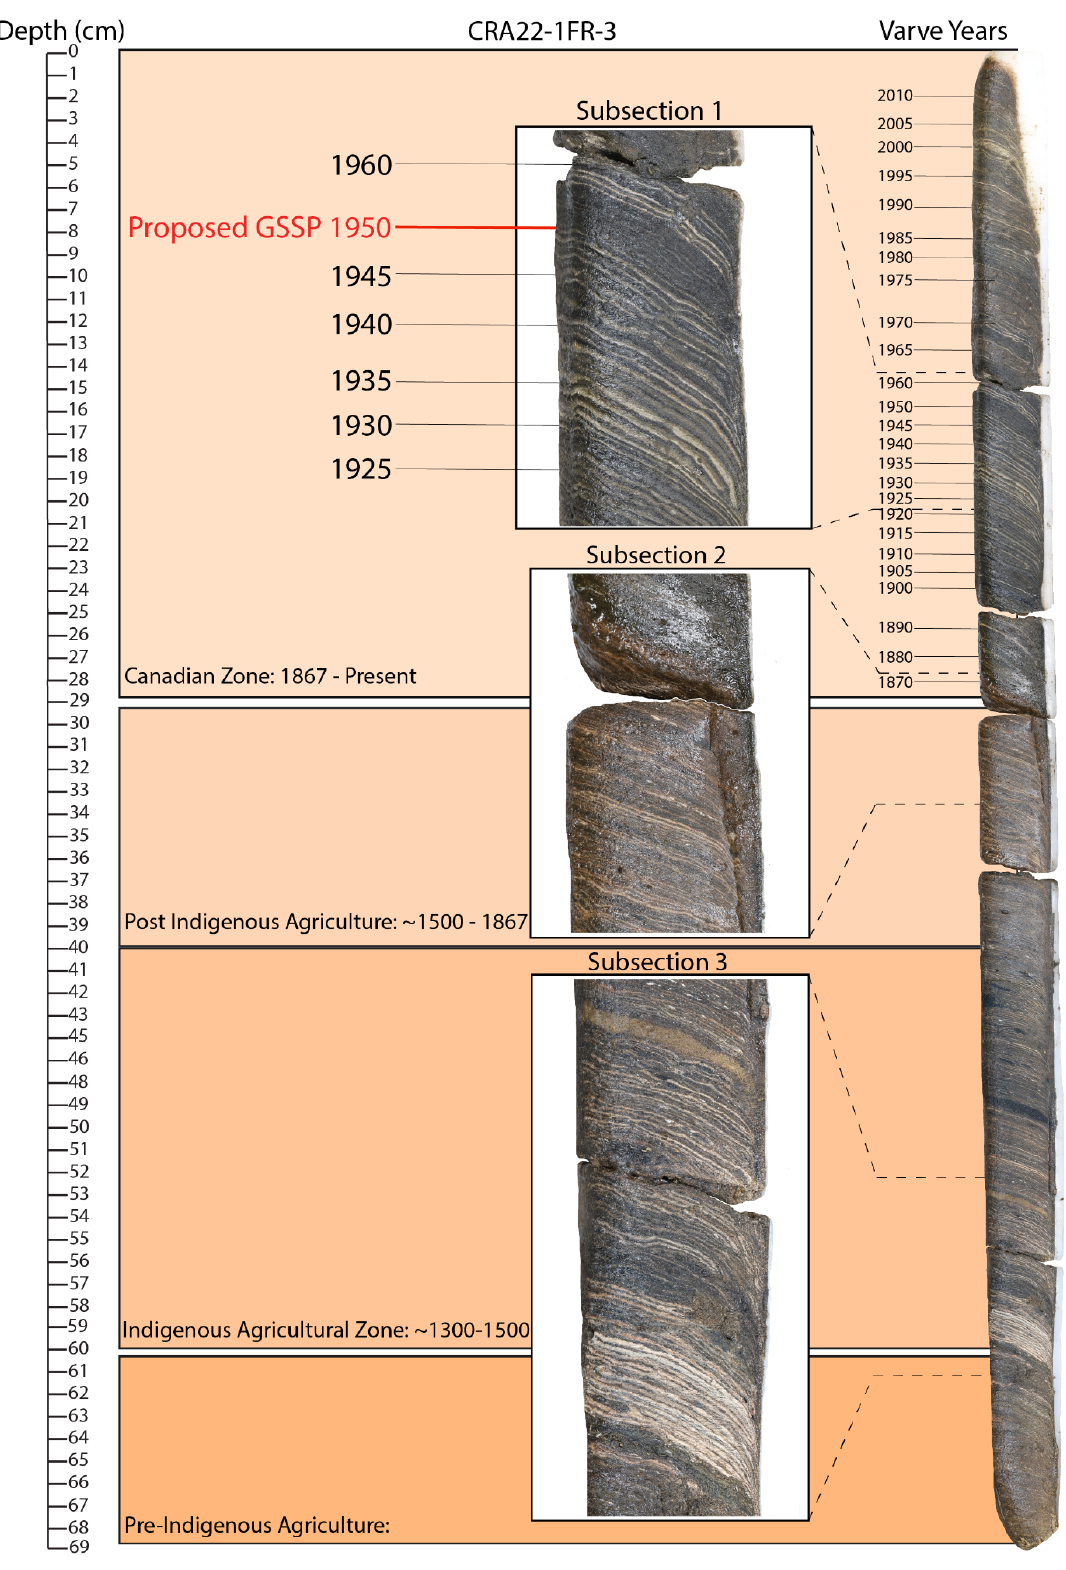
Figure 7. Core-CRA22-1FR-3. Core taken February 2022 for GSSP archive at the Museum of Nature, Ottawa, ON. The greater warping evident in the cross section reflects longer residence time of the sampler in the substrate during the 2022 expedition to recover thicker sediments to the lakebed.